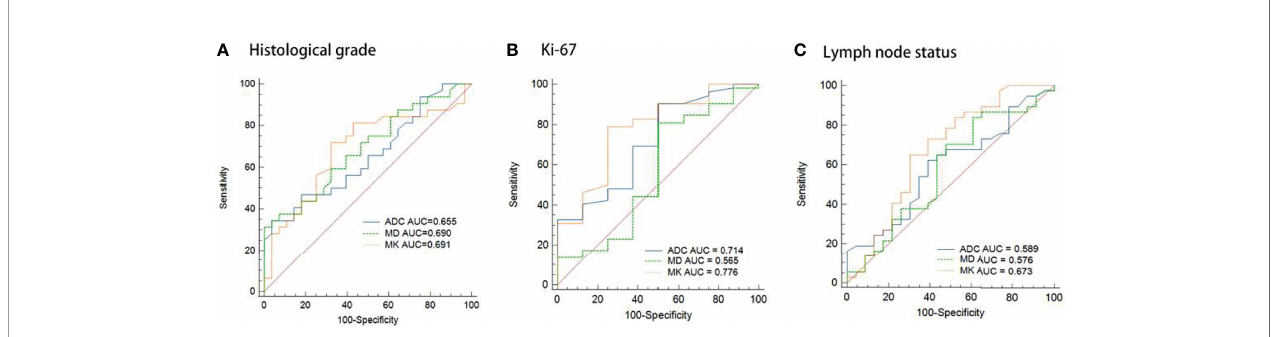
FIGURE 4 | Comparison of the diagnositic performance for ADC, MD and MK in predicting histological grade (A) , Ki-67 expression (B) and Lymph node status (C) .